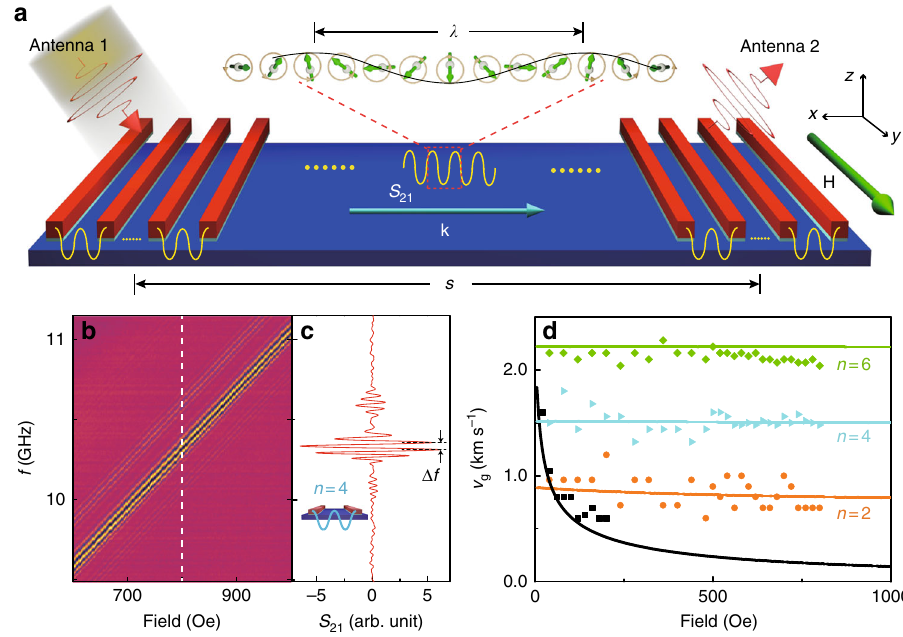
Fig. 2 Propagating short-wavelength spin waves and their group velocities. a Sketch of a YIG/Ti/Co heterostructure-based device for spin-wave propagation measurements. The external fi eld H is in the plane and parallel to the Co nanowires. b Color-coded transmission spectra S 21 measured on a YIG/Ti/Co device with a nanowire period of 200 nm (device A1). The fi eld is set to − 3000 Oe fi rst and then swept from 600 Oe to 1000 Oe with a fi eld step of 2.5 Oe. c A line plot extracted as a cutoff from b at the fi eld value of 800 Oe. Δ f is extracted for the calculation of the group velocity. d Group velocities of different spin-wave modes. Black squares show the group velocities of CPW-excited spin waves in the 20-nm-thick plain YIG fi lm extracted from the experimental data on a YIG/Ti/Co structure with a nanowire period of 180 nm (device A2). Yellow circles, blue triangles, and green diamonds show the PSWSW group velocities extracted from the experimental data with mode number n = 2, n = 4, and n = 6, respectively. The solid lines are the group velocities calculated based on the derivative of the spin-wave dispersion relation in the YIG fi lm